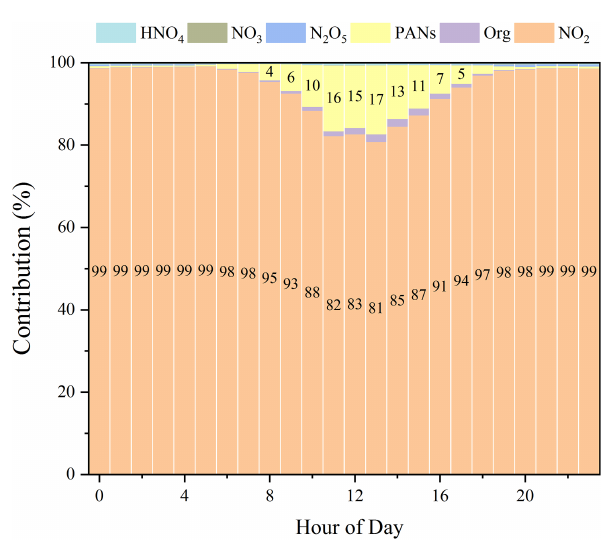
Figure 4. Relative contribution of each NO ∗ PANs = PAN + PPN + MPAN. Org represents organic nitrates ∗ (RONO 2 + ROONO 2 ).